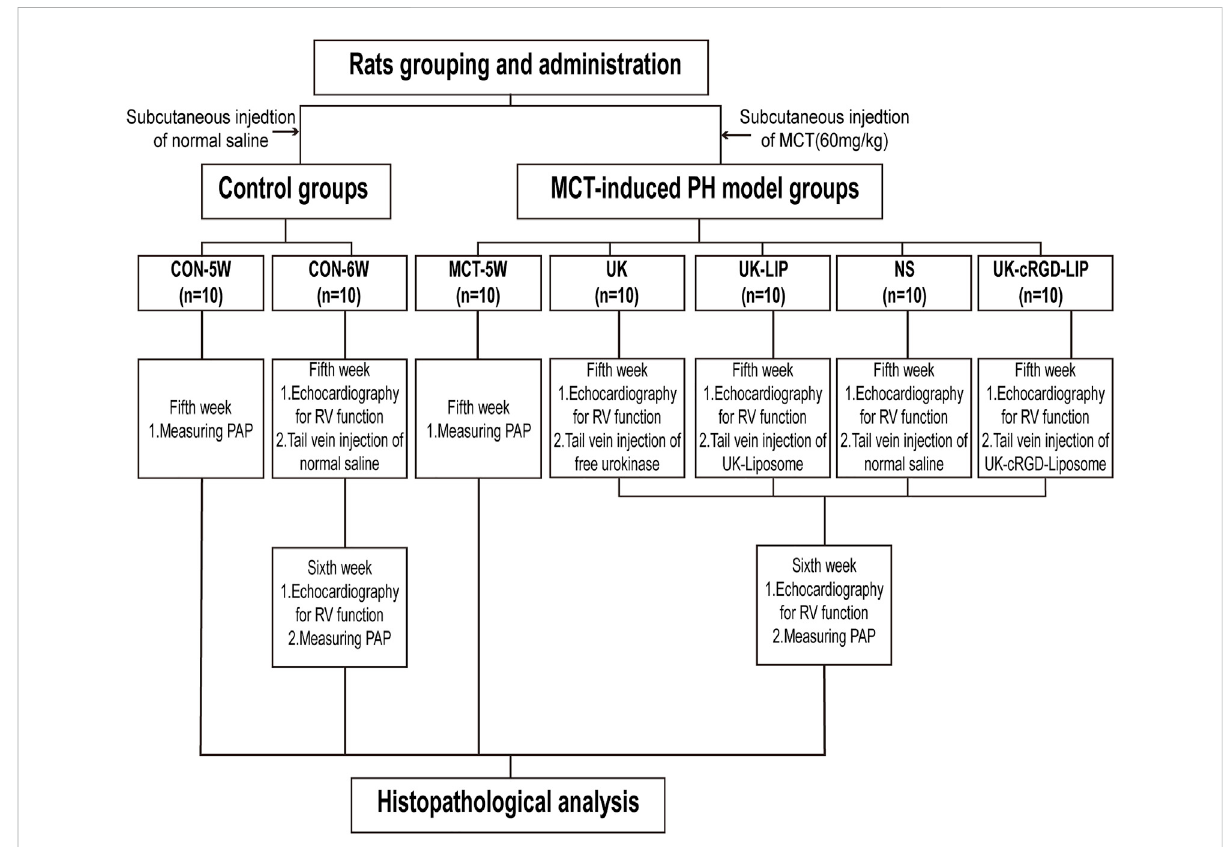
FIGURE 2 Flowchartofgroupingandadministrationofratsineachgroup.Abbreviations:MCT,monocrotaline;RV,rightventricular;PAP,pulmonaryartery pressure; UK-Liposome, urokinase-loaded liposome; UK-cRGD-Liposome, urokinase-loaded cycle RGD-decorated